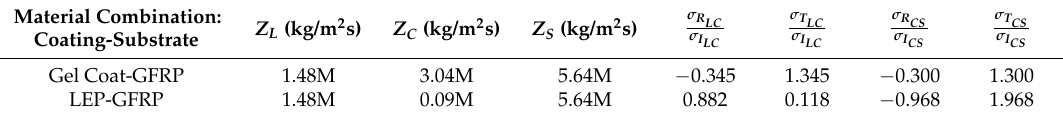
Table 1. Impedance properties of selected candidate materials. Reflected and transmitted waves as a function of the incident stress at the surface (liquid–coating) and at the interface (coating–substrate). Material Combination: Z L (kg/m 2 Coating-Substrate